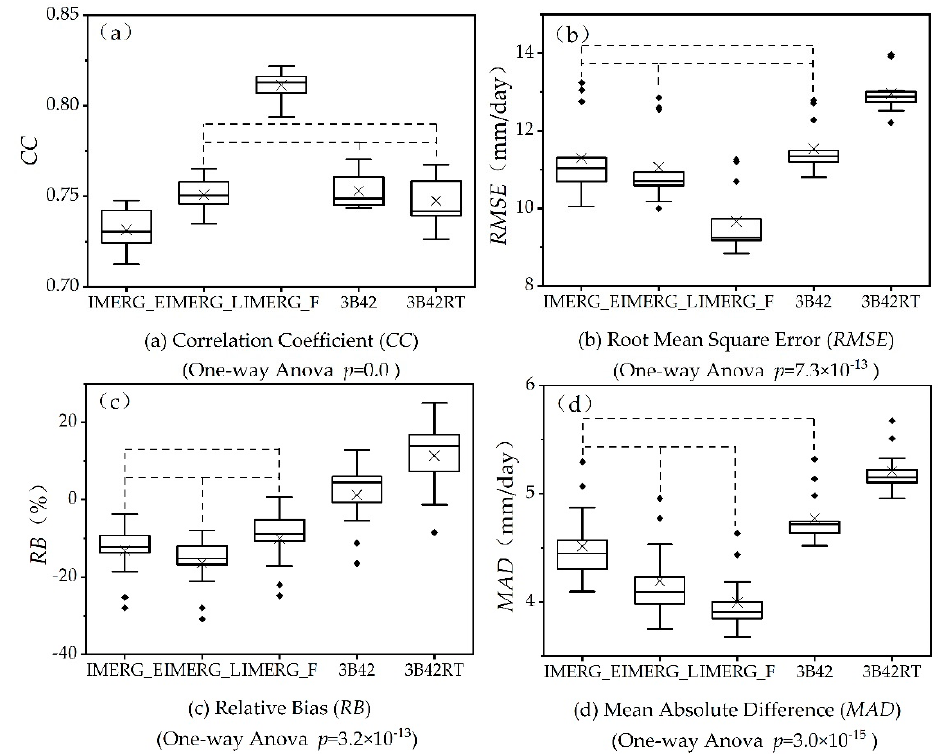
Figure 4. Boxplots of the four annual continuous evaluation metrics of SPPs at daily scale: ( a ) Correlation coe ffi cient ( CC ) (Levene’s Test, p = 0.08; One-Way ANOVA, p = 0.0); (b) Root-mean-square error ( RMSE ) (Levene’s Test, p = 0.16; One-Way ANOVA, p = 7.3 × 10 − 13 ); ( c ) Relative bias ( RB ) (Levene’s Test, p = 0.78; One-Way ANOVA, p = 3.2 × 10 − 13 ); and (d) Mean absolute di ff erence ( MAD ) (Levene’s Test, p = 0.35; One-Way ANOVA, p = 3.0 × 10 − 15 ). Two SPPs are connected with a black dotted line if posterior comparison tests have concluded a non-significant di ff erence between their means at α = 0.05. Each boxplot is used to depict the distribution, therefore the variation, of the continuous evaluation metrics among the 13 rainfall stations. In each boxplot, the top and bottom of the box represent the first and third quantiles. The whiskers extends to 1.5 times of the inter-quantile range. The horizontal line inside the box represents the median. The ‘ × ’ inside the box represents the